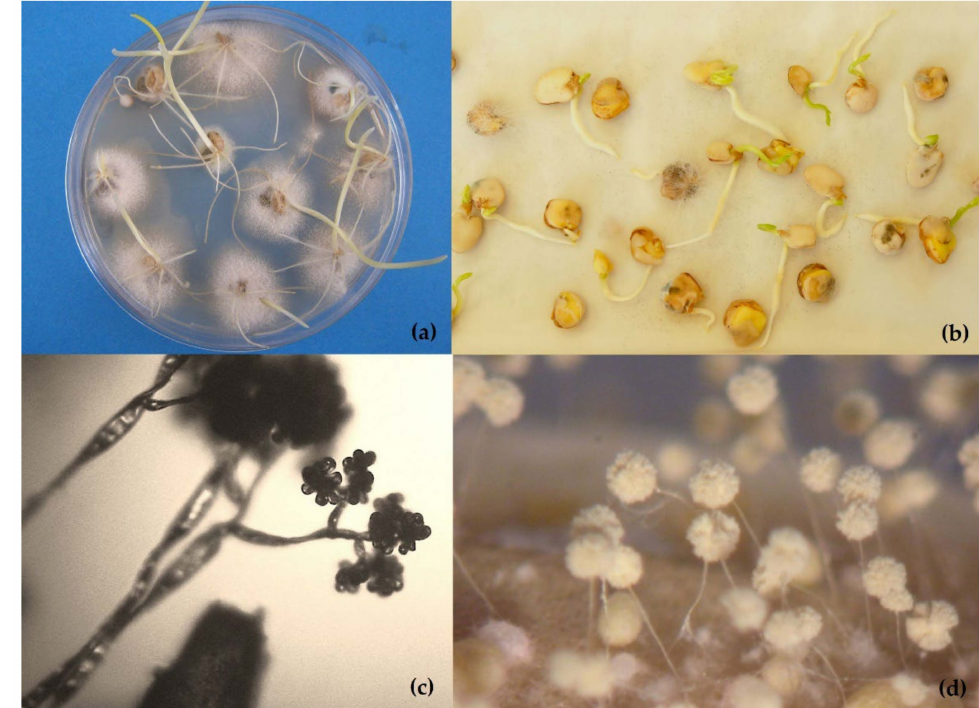
Figure 1. Conventional methods of detection of fungal pathogens in seeds: ( a ) wheat seeds infected with Fusarium under agar media test; ( b ) germinating seeds of Lathyrus sativus under blotter testing method after 40 years of storage at the CRF-INIA gene bank; ( c ) morphology of conidiophores and typical conidia of Botrytis spp.; ( d ) Aspergillus spp. by optical